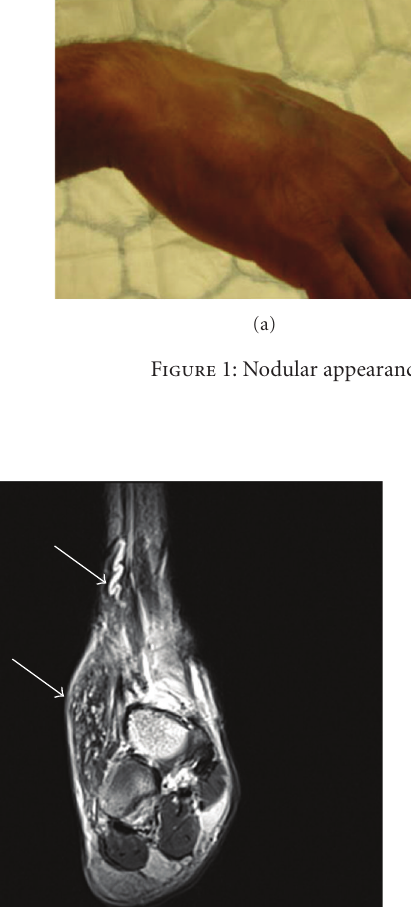
Figure 2: Coronal T1 MRI of right foot large subcutaneous soft tissue lesion anterolaterally (arrow) with a large prominent proximal feeding vessel